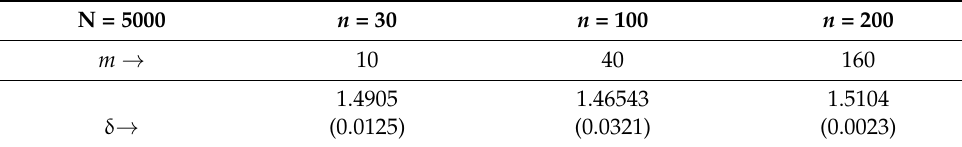
Table 6. The MLE of the parameter with quadratic error (in brackets).